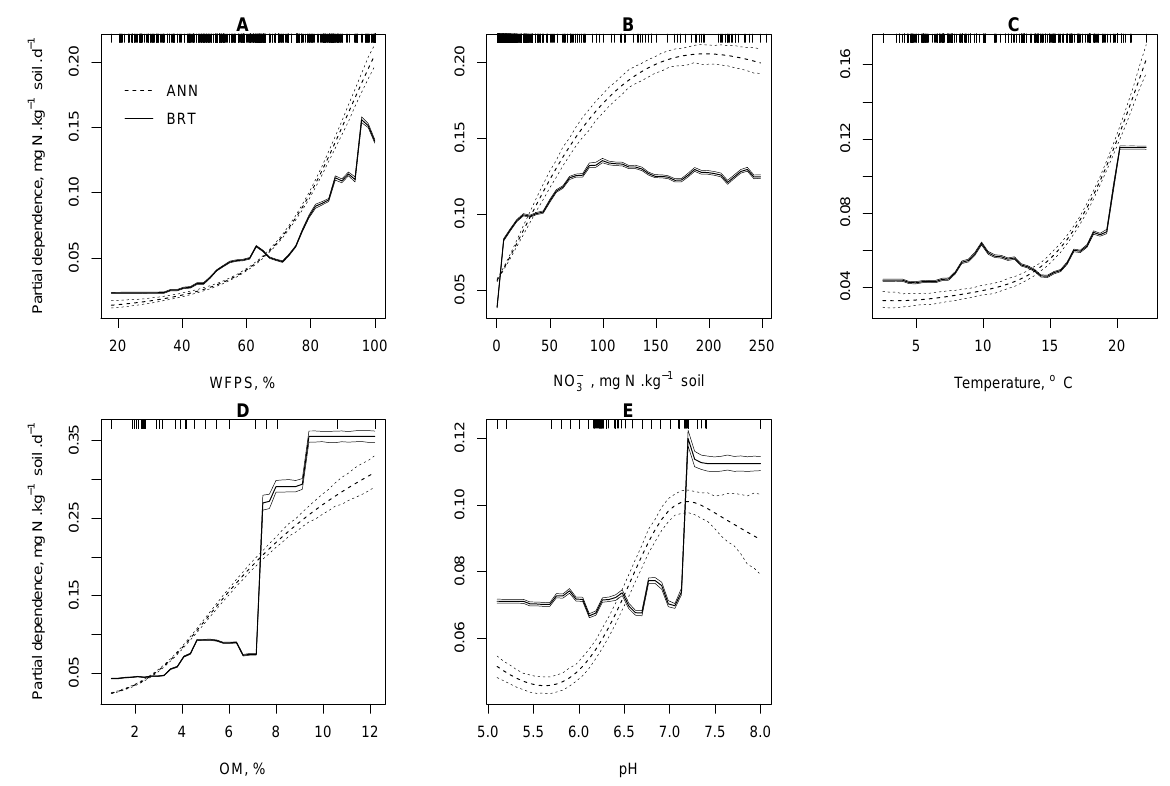
Fig. 8. Mean partial dependence of BRT5(OM,pH)G and ANN5(OM,pH)G models, with 95% confidence intervals (bootstrap). Rug plots on each subplot indicate the presence of the x-axis data in the dataset (e.g. only few different values of pH are present in the original dataset and so few lines appear in the rug plot of subplot